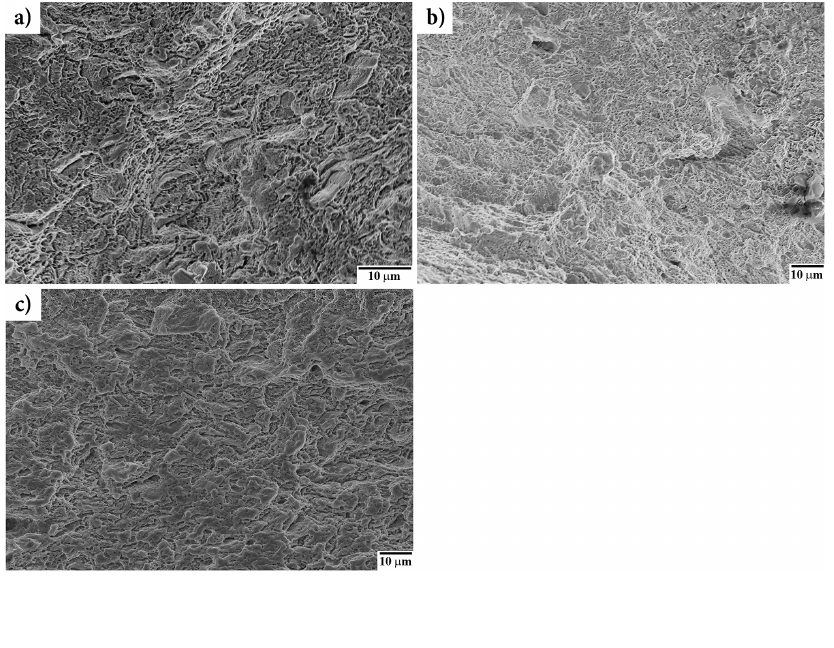
Figure 5: Fracture features of tensile- tested T92 steel samples solutionized at 1,050°C and tempered at (a) 730°C, (b) 745°C and (c)